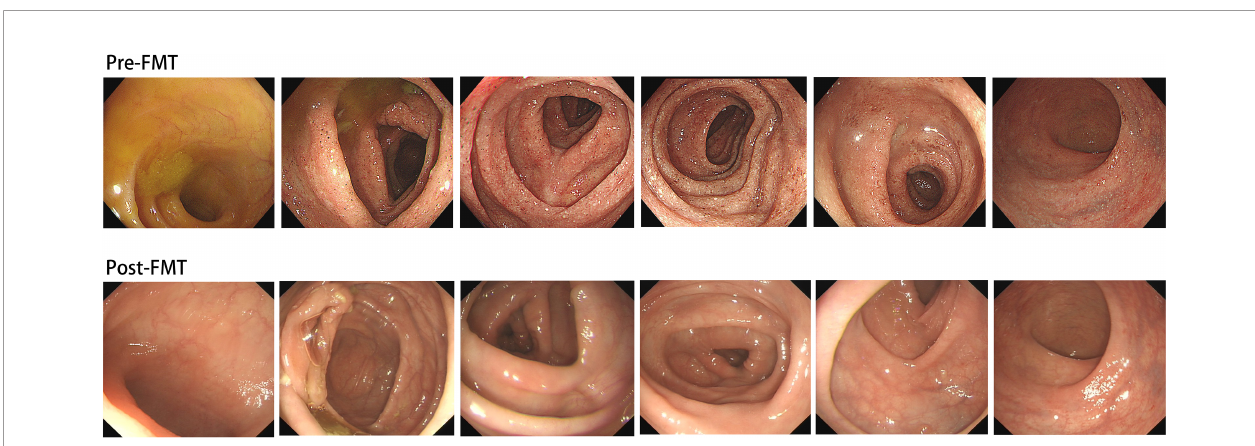
FIGURE 2 | Colonoscopy manifestation before fecal microbiota transplantation but following glucocorticoid treatment and two doses of vedolizumab treatment; Colonoscopy evaluation after fecal microbiota transplantation suggests that the colon and rectum mucosa return to normal.